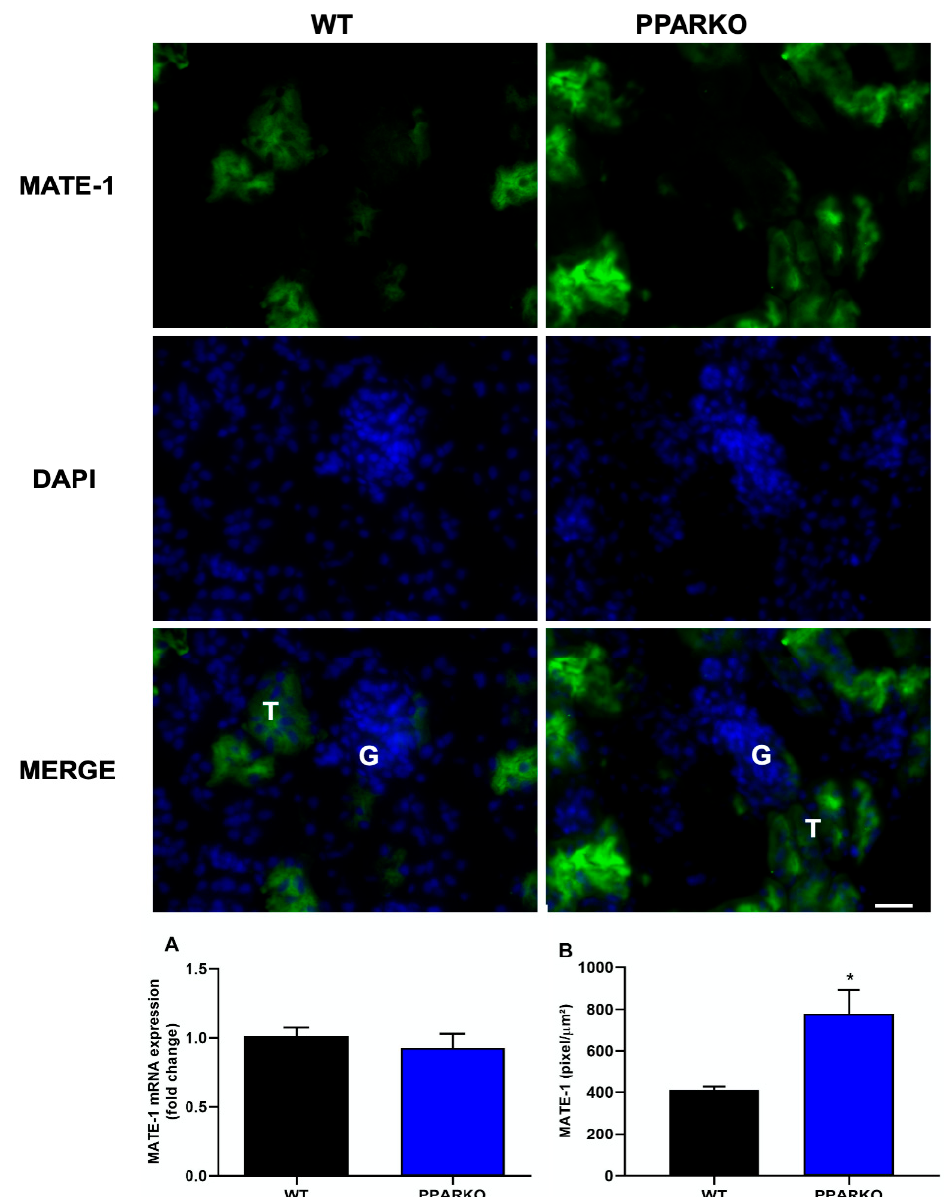
Figure 5. PPAR- α absence enhances protein expression by immunofluorescence of multidrug and toxin extrusion 1 (MATE-1). ( A ) No differences between WT and PPARKO mice were found in MATE- 1 mRNA levels. ( B ) However, PPAR- α knockout mice enhanced MATE-1 protein levels. G to indicate glomeruli and a T to indicate tubules. n = 5 per group. Scale bar = 100 µm. Two-tailed Student´s t-test. * p < 0.05, compared to the WT group.